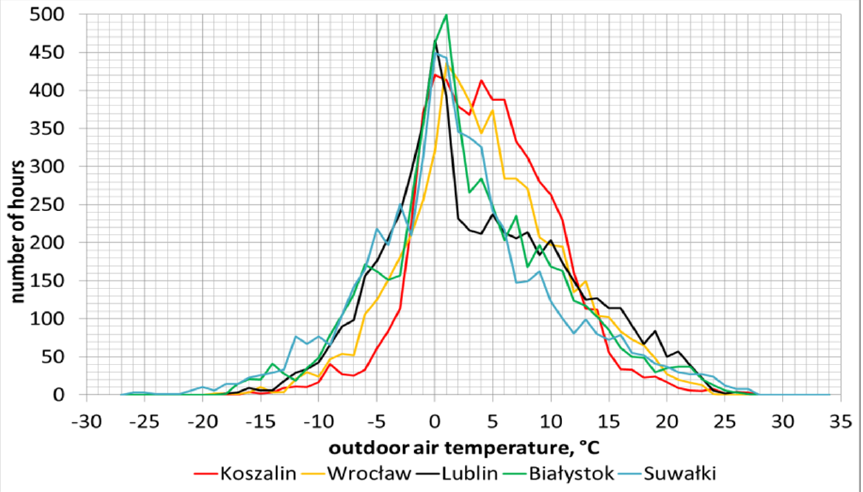
Figure 2. Comparison of the frequency of outdoor air temperatures at the analyzed locations, excluding the months of June to September, based on [50].